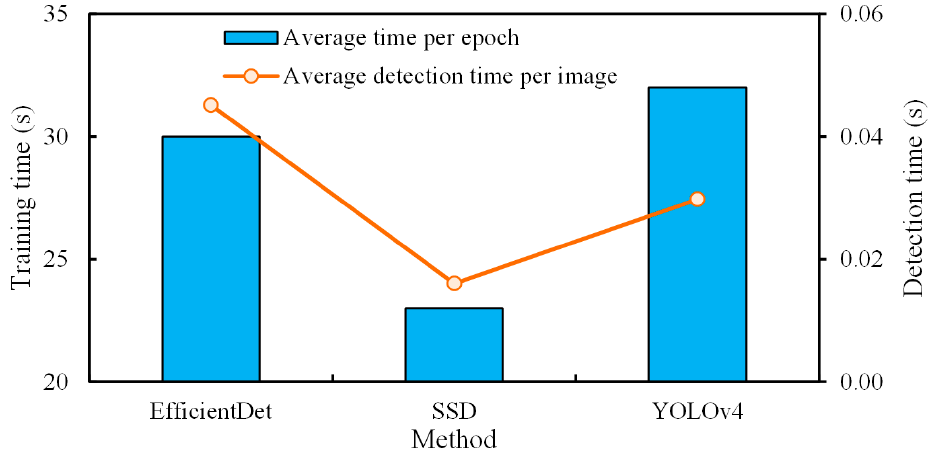
Figure 9. Comparison of the computational time of three different deep learning methods.